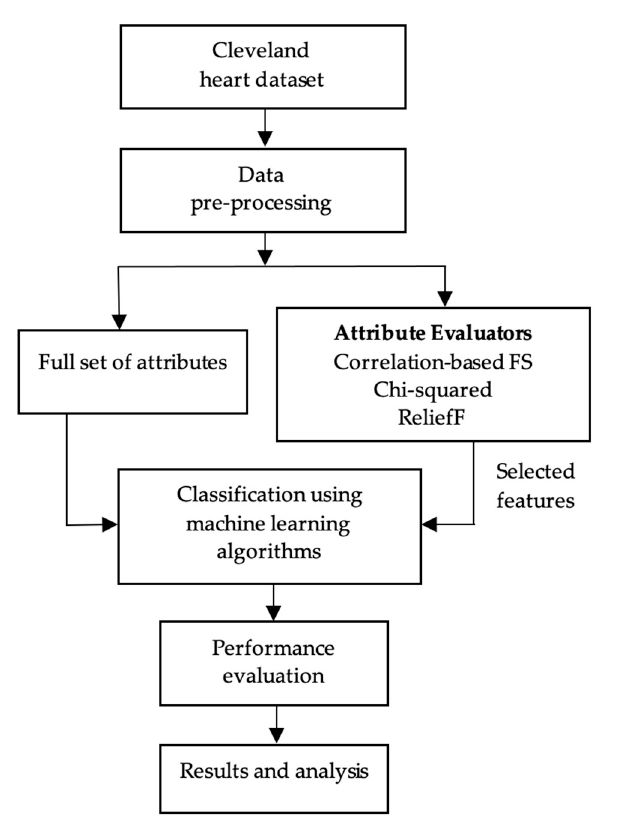
Figure 1. Experimental workflow of the proposed methodology.